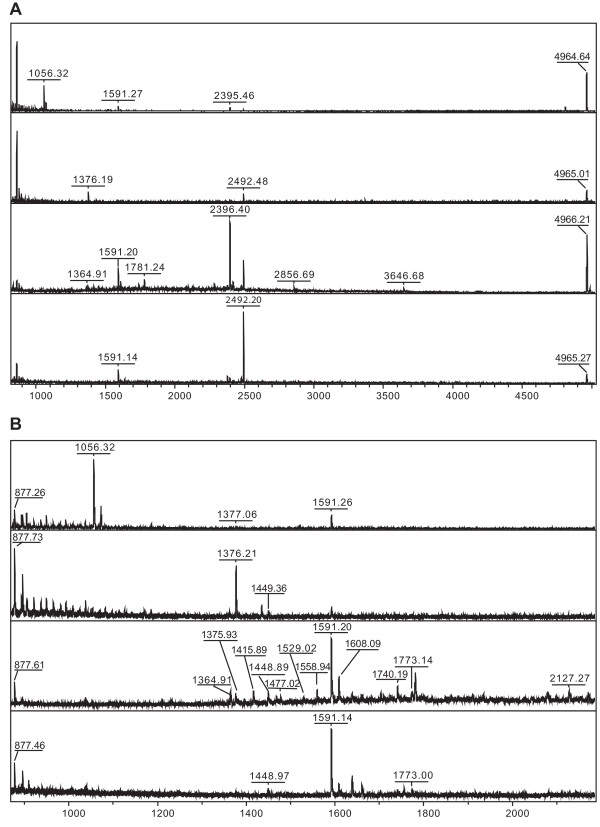
Peptide profiling of the four major song nuclei by mass spectrometry. The homogenates of four major song nuclei (from top to bottom: LMAN, Area X, HVC, and RA) were analysed by MALDI-TOF MS. (A) Peptide profile of four song nuclei in the m/z range of 870-5000. (B) Magnified spectrum between 870-2200 m/z. The individual peaks were mass-matched to peptides previously shown to be present in the brain via tandem mass spectrometry.